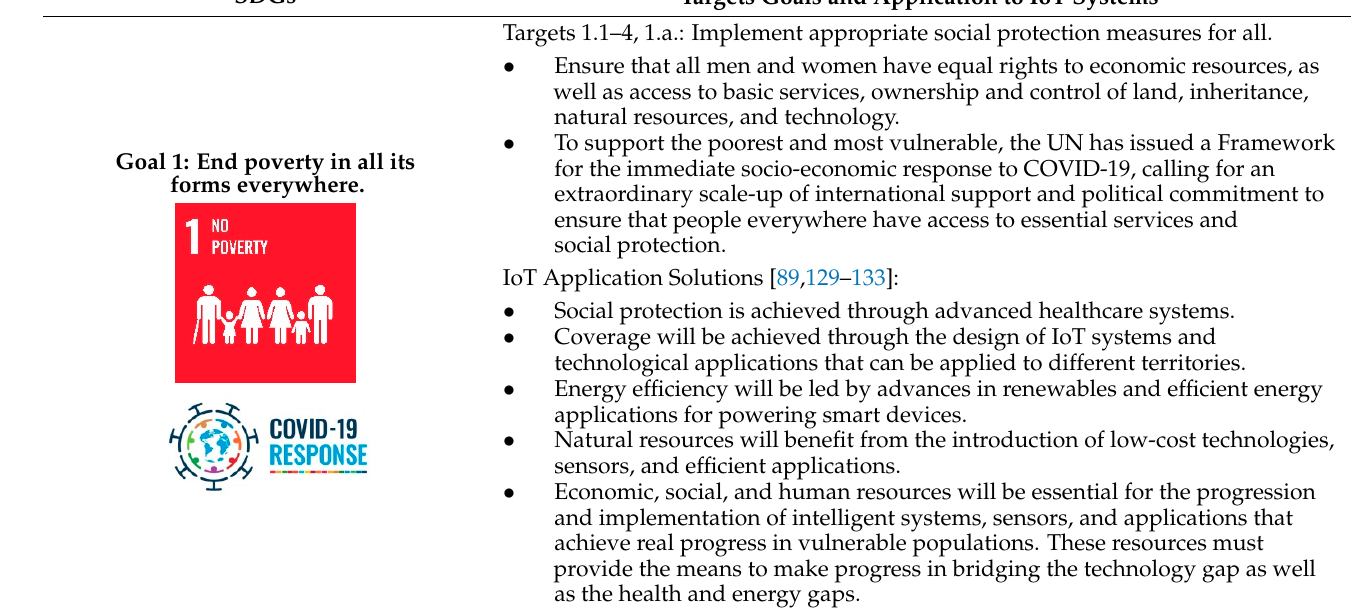
Goal 1: End poverty in all its forms everywhere.